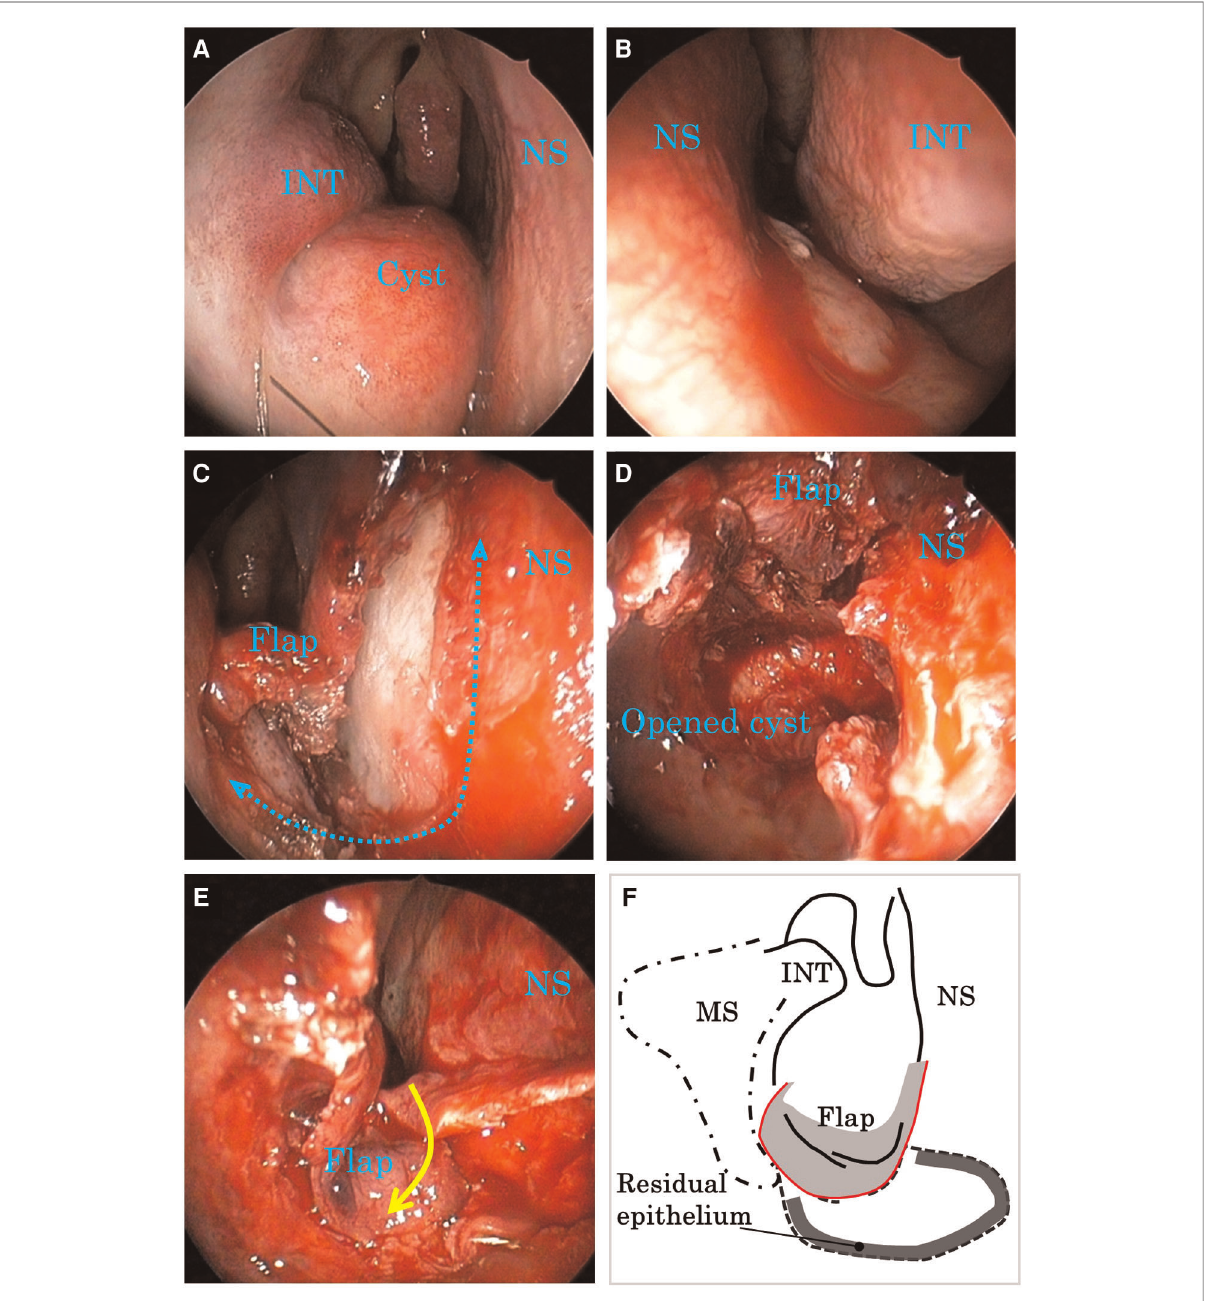
FIGURE 2 Intraoperative endoscopic images and schematic view. ( A ) Right nasal cavity at the beginning of the operation. ( B ) Left nasal cavity at the beginning of the operation. ( C ) Right nasal cavity after L-shaped mucosal incision. ( D ) Right nasal cavity after resection of the nasal part of the cyst. ( E ) Right nasal cavity after marsupialization of the cyst. ( F ) Schematic view of the surgery. INT, inferior nasal turbinate; MS, maxillary sinus; NS, nasal